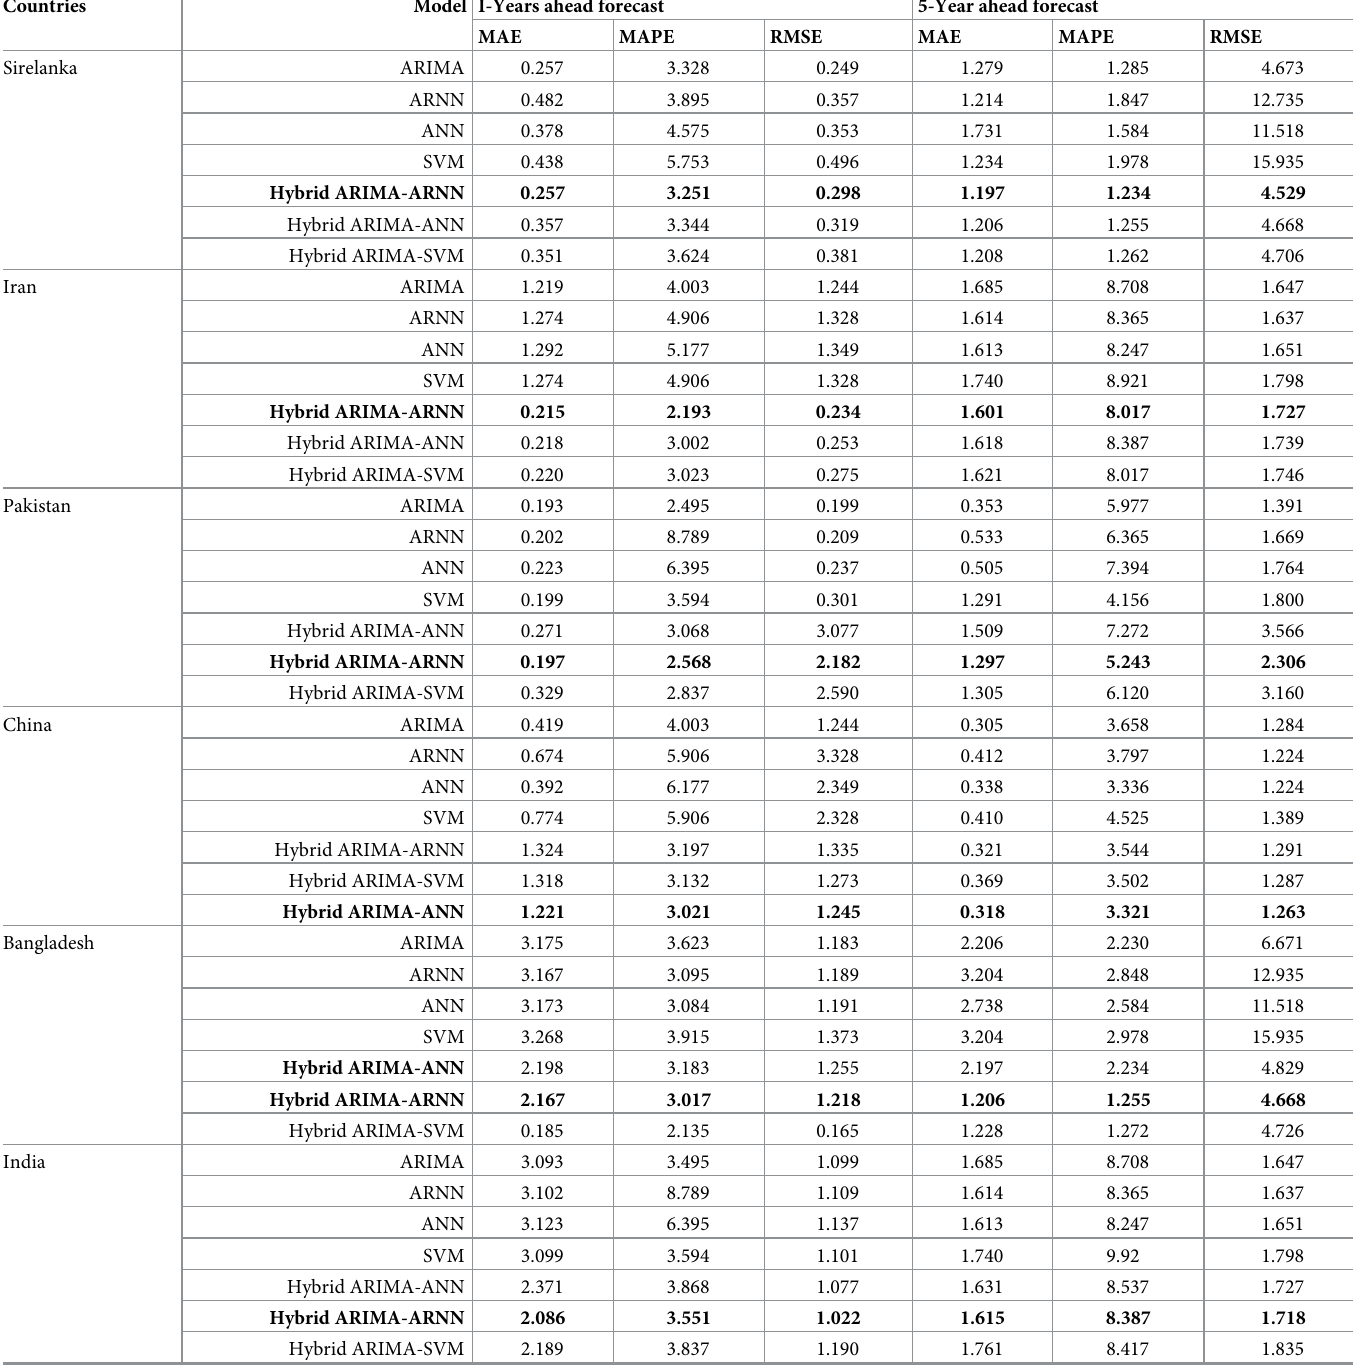
Table 3. Performance evaluation metrics for hybrid prediction models for developing countries of